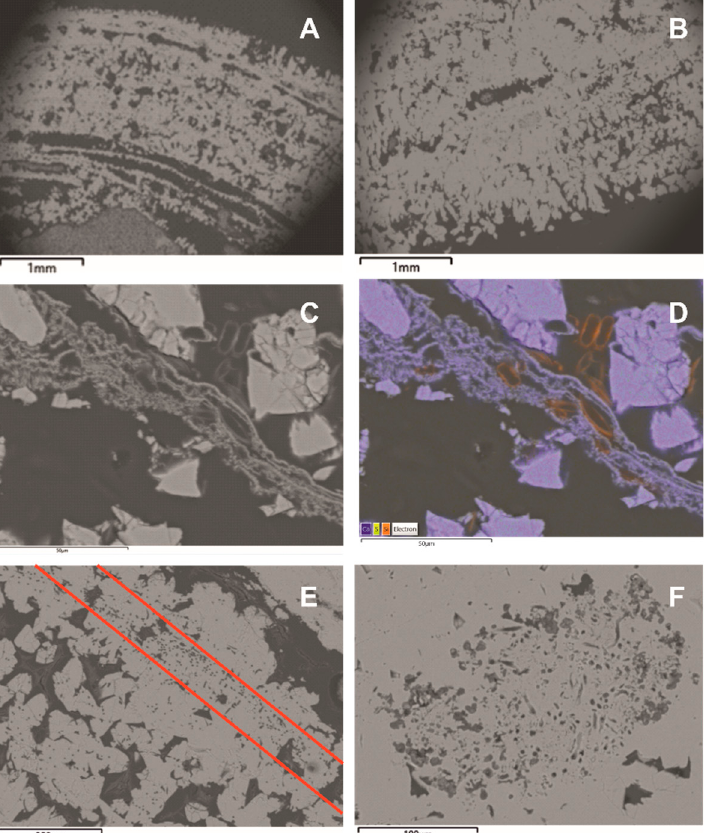
Figure 5. Back-scattered electron images (BSEI) presenting ( A ) laminated facies of stalactite, ( B ) lam- inae with shrubs that expand upward by irregular branching, ( C ) laminae consisting of micritic crystals of calcite and into it diatoms are trapped, ( D ) false color BSEI, derived from the correspond- ing black and white BSEI (see ( C )), displaying the distribution of Ca (purple), S (yellow) and Si (orange) where the diatoms are distinct, ( E , F ) holes and grooves in calcite crystals, suggesting the presence of endolithic Cyanobacteria.